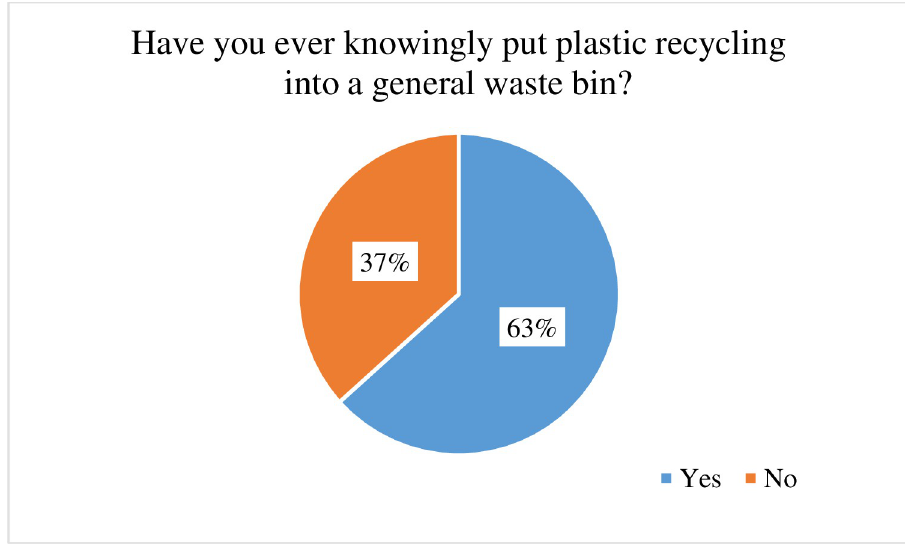
Fig 2. Responses to online survey selected items (motivation and opportunity) (agree and strongly agree percentage scores are combined).